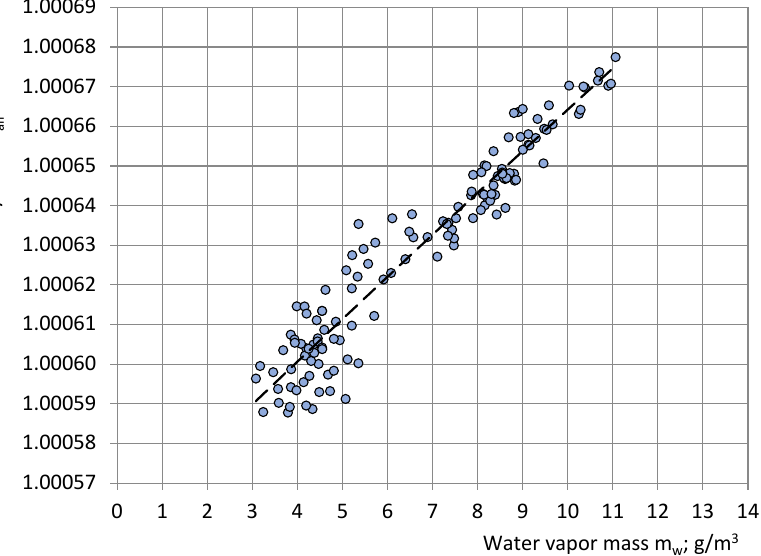
Figure 15. Correlation between the permittivity ε air of air in the test room and water vapour mass m w of air in the test room (short series).